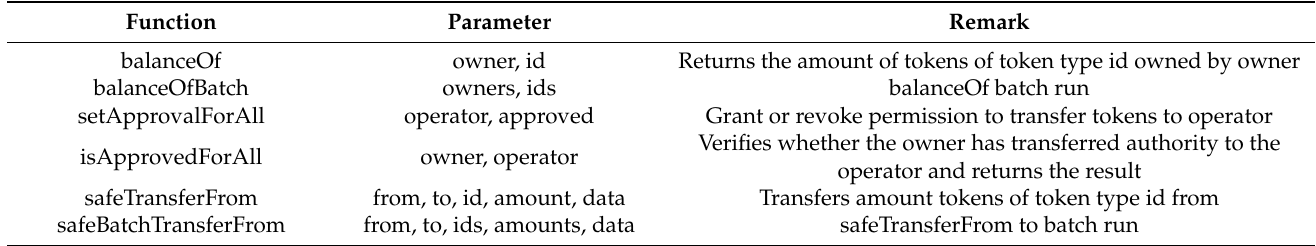
Table 4. Ethereum Multi-token standard ERC-1155 interface function list.